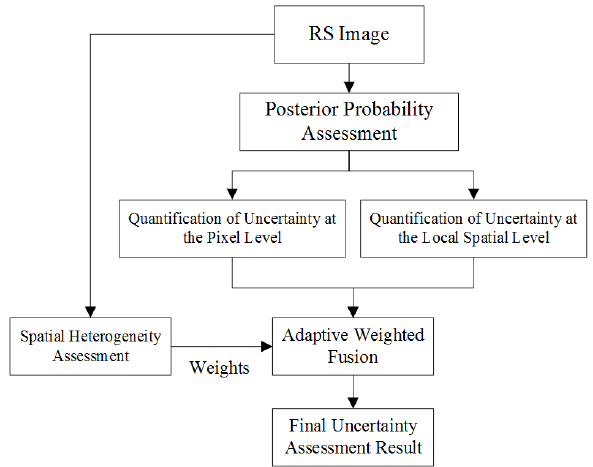
Figure 2. Flowchart of the proposed